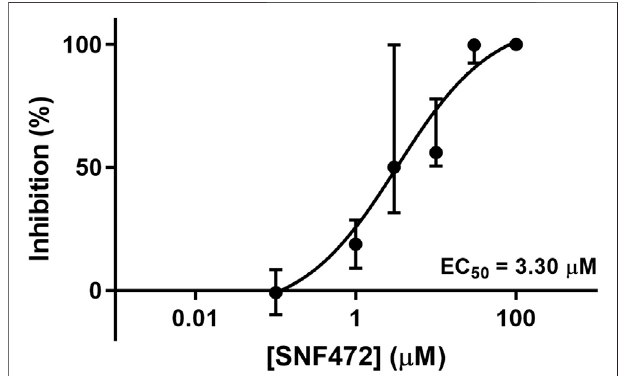
FIGURE 3 | Dose-response curve of the inhibitory effects of SNF472 in whole pig lea fl et calci fi cation in antimyo fi broblastic medium under osteogenic stimulation. Data is shown as median ± interquartile range.